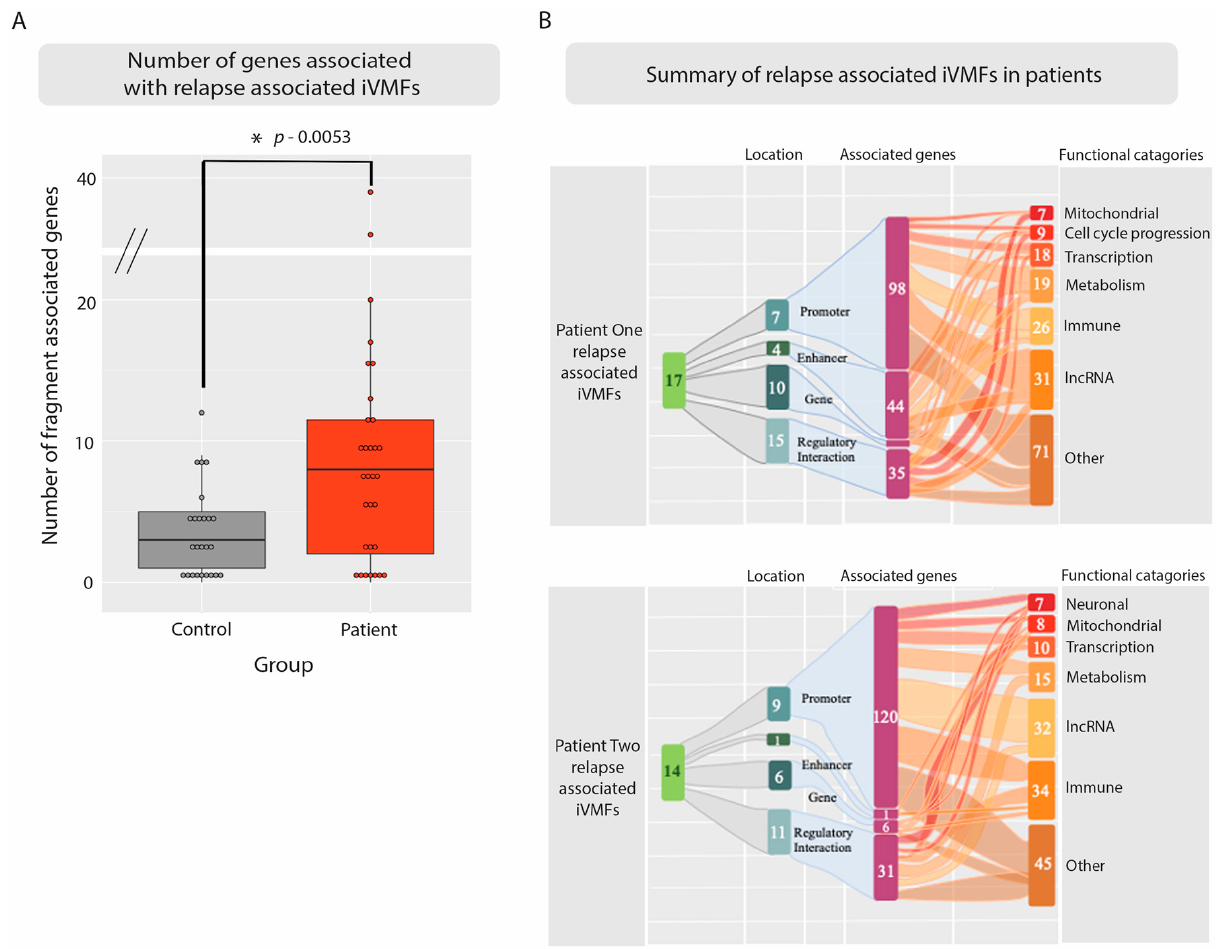
Figure 5. Investigation of the genes associated with relapse associated ME-iVMFs. ( A ) Box plots showing the number of genes linked with each statistically significant variably methylated fragment associated with a ‘simulated’ relapse event for the control in grey (in two analyses using each of the patient health relapse time points) and the ‘real relapse events’ of the two patients in red. Each point represents a fragment with the number of associated genes shown on the y -axis. The mean number of genes associated with the identified fragments for the patient and control groups is shown with the horizontal line. An unpaired t -test resulted in a significance value of p = 0.0053. ( B ) Sankey plot showing relationship between the variably methylated fragments identified in each patient associated with a relapse event and the biological functions they associate with through various regulatory genomic elements of relevant genes. From the statistically significant variably methylated fragments identified for each individual the location was determined and relevant regulatory interactions were recorded from UCSC genome browser. A gene list was compiled of genes associated with these regulatory interactions and the functional annotations were utilised to place them into categories. Some genes fell into multiple categories with others having no known function. Tables showing the full gene list, function and functional category is included in Supplementary Excel File ‘Supplementary.xlsx’ sheet ‘Genes_associated with P1’ and ‘Genes associated with